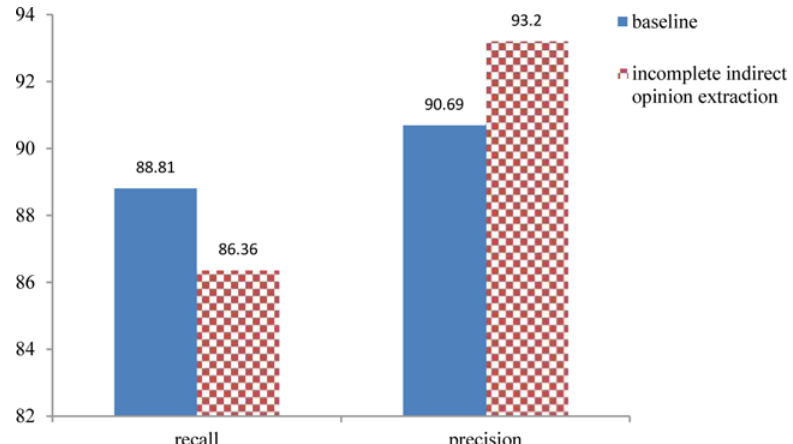
Fig 6. Comparison of the proposed method for incomplete indirect opinion extraction with the baseline method